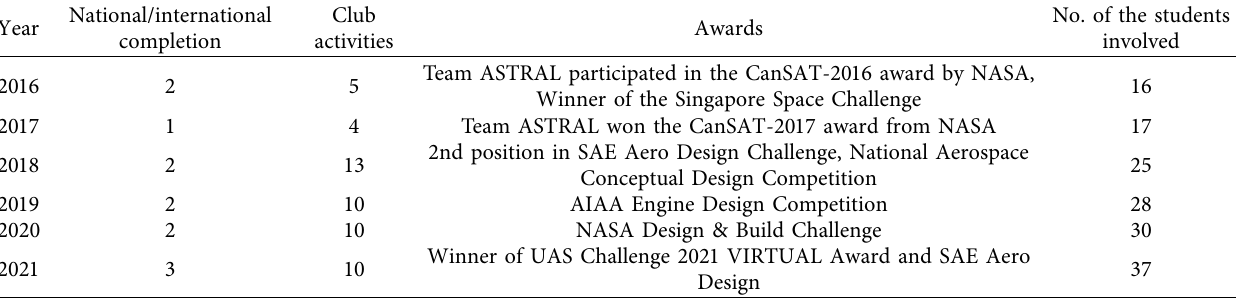
Table 3: Technical competitions.